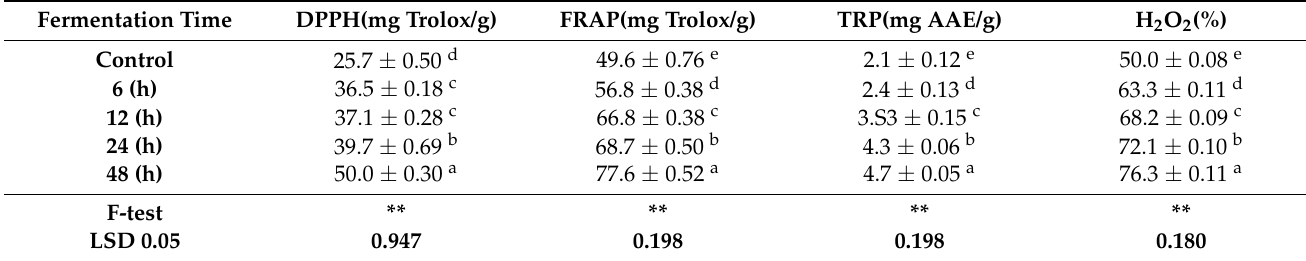
Values are means ( ± SD) of triplicate samples. Means not sharing a common superscript letter in a column are significantly ** different at ( p < 0.05). Means in the same column without a superscript are not significantly ( p < 0.05) different, ns; no significant difference at ( p < 0.05) as assessed by least significant difference